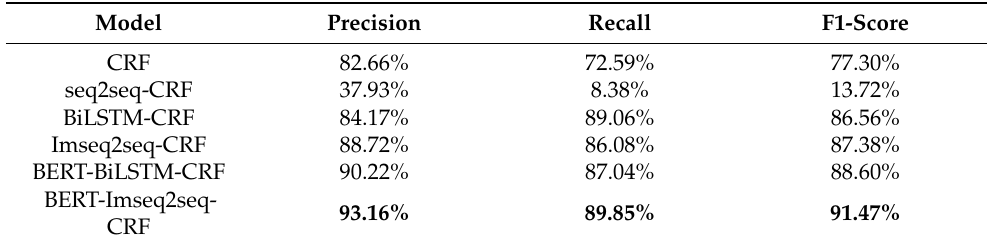
Table 4. Identification results of hot strip